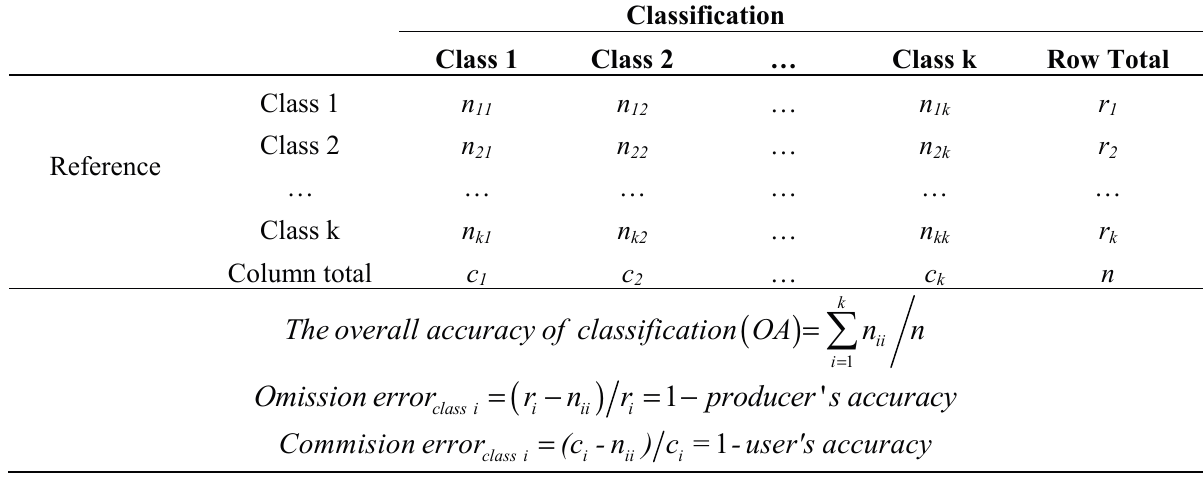
Table 1. Confusion matrix and the overall accuracy of